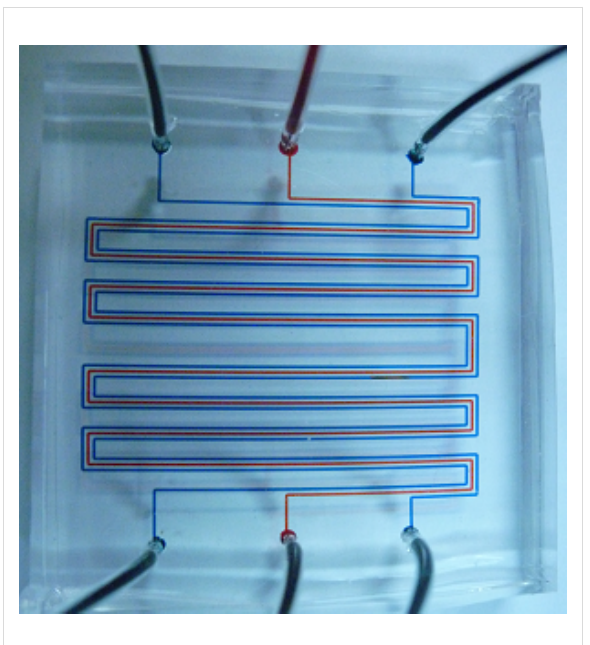
Figure 2: Optical image of the triple-channel microreactor (for demon- stration purposes, the inner channel for reaction is filled with red solu- tion and outer channels for gas with blue